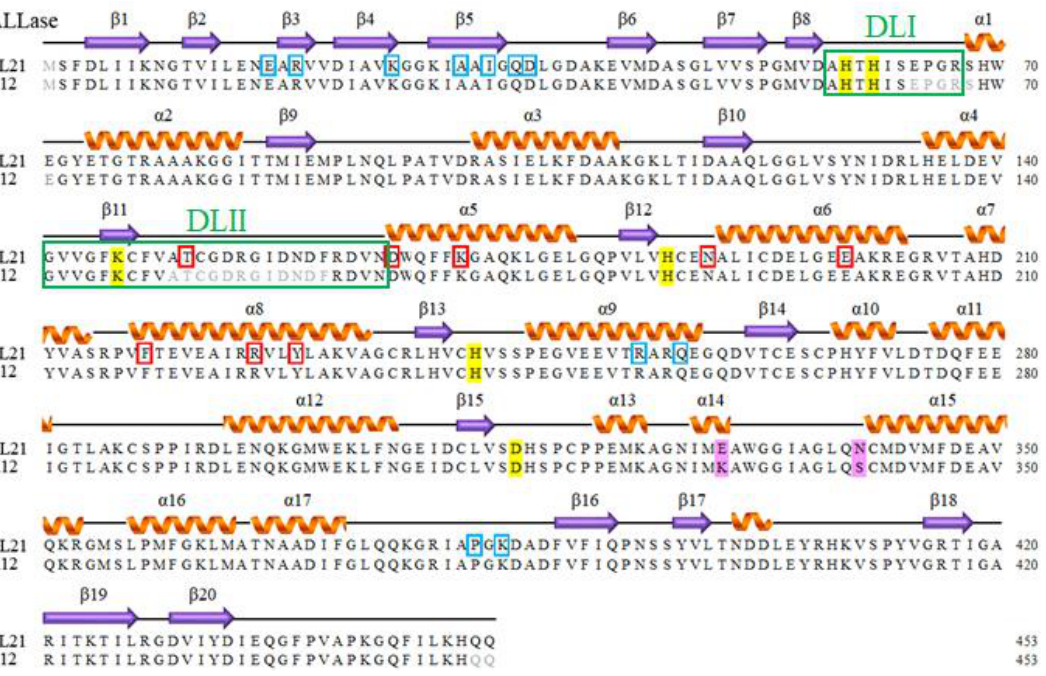
Figure 2. Sequence alignment of EcALLase-BL21 and EcALLase-K12. The secondary structural elements of EcALLase-BL21 are shown with the sequence. The active site dynamic loop I (DLI; A58–R67) and dynamic loop II (DLII; G141–N165) are boxed in green. The unobserved residues 64–68, 150–161, and 452–453 in EcALLase-K12 ternary structure were colored in grey. In comparison, these residues in the structure of EcALLase-BL21 were clearly found. The metal-binding sites are shaded in yellow. The amino acids that are involved in monomer–monomer interface via hydrogen bonding are boxed in red. The amino acids that are involved in dimer–dimer interface via hydrogen bonding are boxed in blue. In comparison, only two residues of EcALLase-K12, i.e., K330 and S340, are different from and replaced with E330 and N34 in EcALLase-BL21 (shaded in